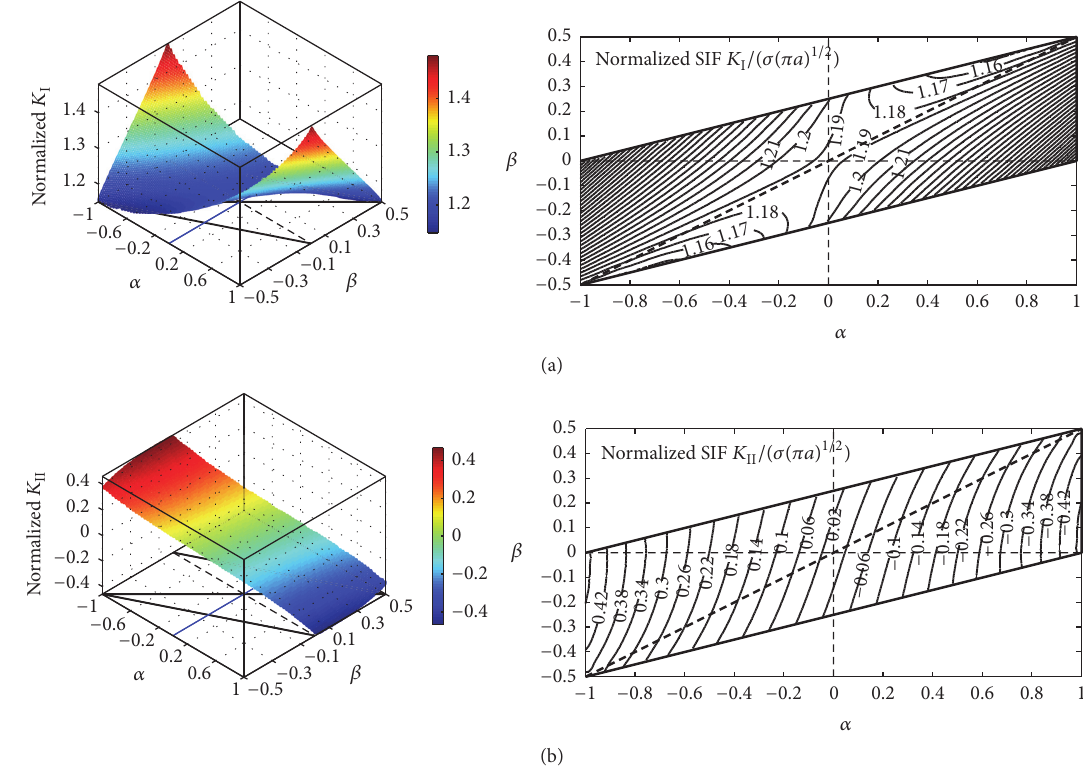
Figure 6: 3D normalized SIFs and contour plots of (a) 𝐾 I /𝜎√𝜋𝑎 and (b) 𝐾 II /𝜎√𝜋𝑎 .